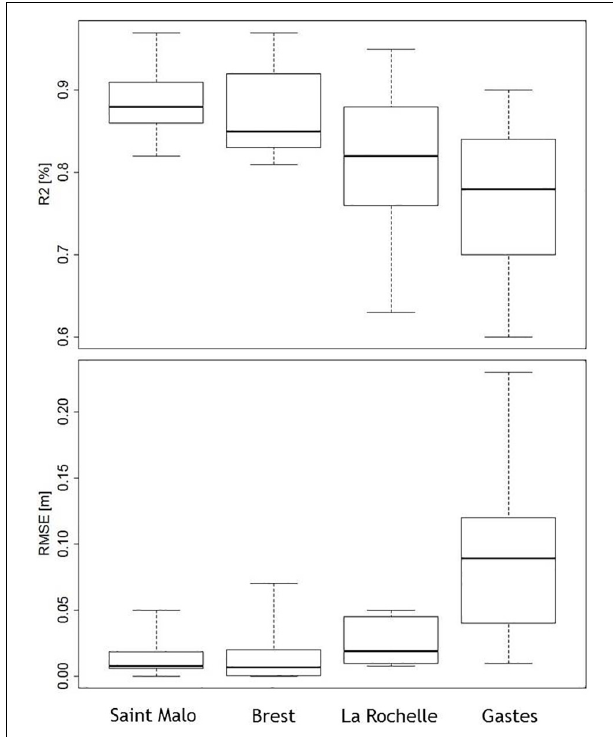
FIGURE 4 | Cross validation results for the four constructed